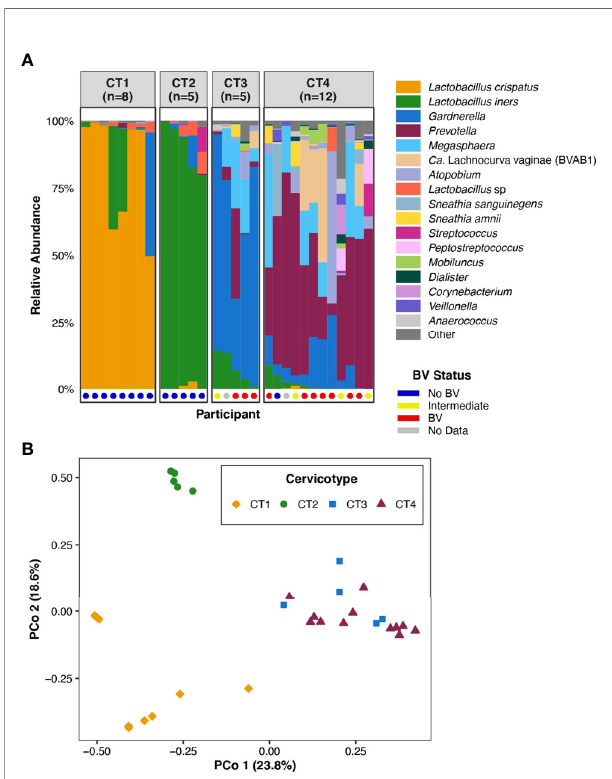
FIGURE 1 | FGT microbiota of the 30 participants included in the analysis. (A) Bar plot representation of the microbial taxa present in the FGT in all participants, grouped by CT. Nugent score was also calculated for 28 of the 30 participants and is represented at the base of the bar plot. (B) Principal coordinates analysis of FGT microbial taxa from the 30